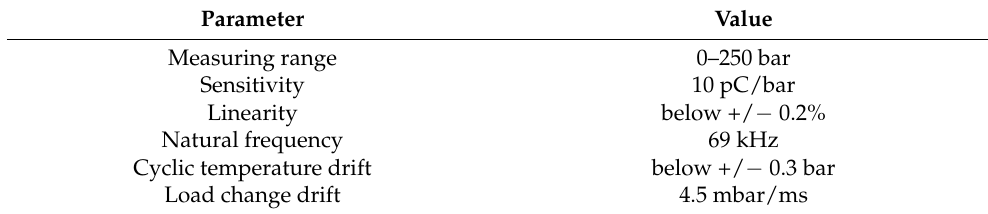
Table 2. Technical data of the AVL QC34D sensor. Developed from [44].